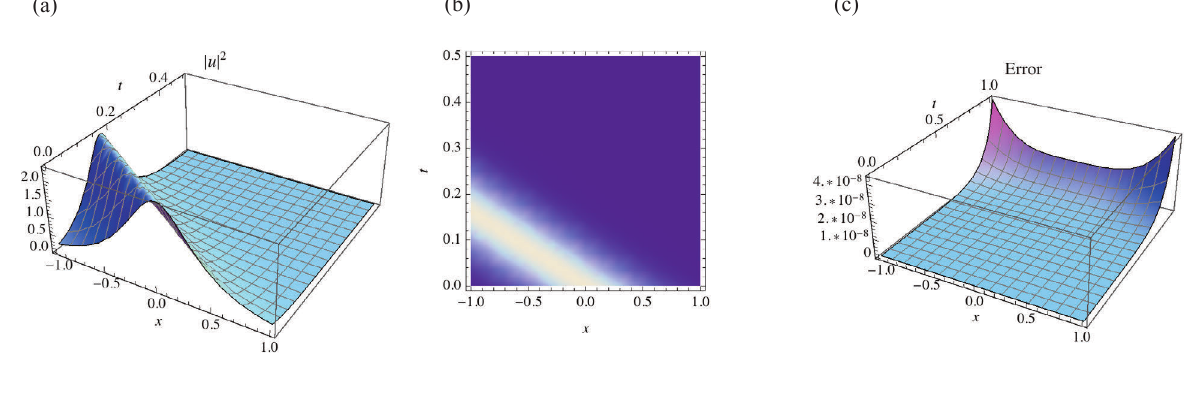
Fig. 1. Graphical representation of the results of example 1: (a) 3D bright soliton, (b) 2D density contour and (c) Absolute error with N = 15 iteration steps.